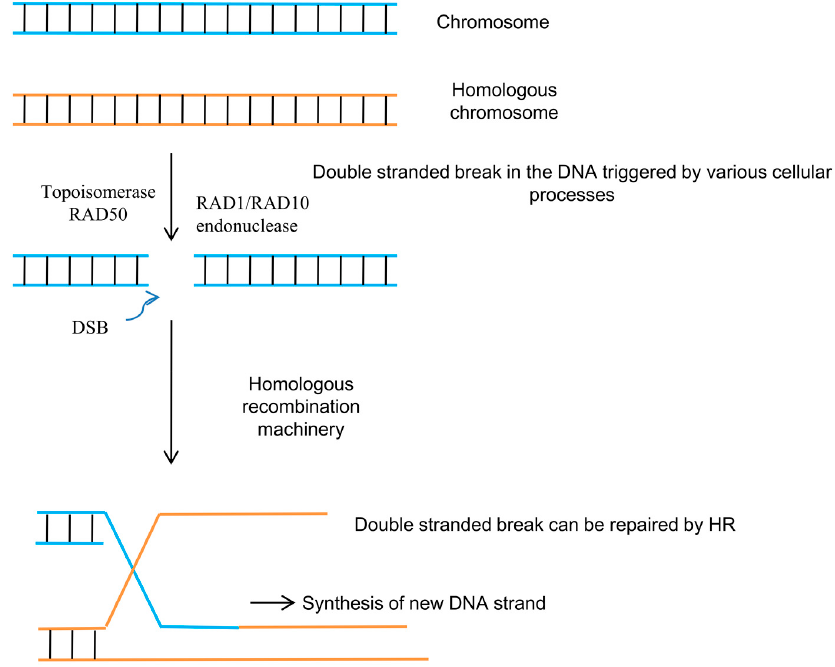
Figure 1. Homologous recombination induced repair of double stranded breaks (DBS). HR: homologous recombination.